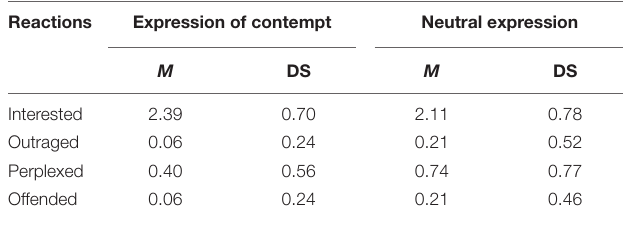
TABLE 2 | Comparison of significantly different medium scores and standard deviation of participants identifying with students in low economic conditions, according to experimental and control conditions (expression of contempt vs. neutral